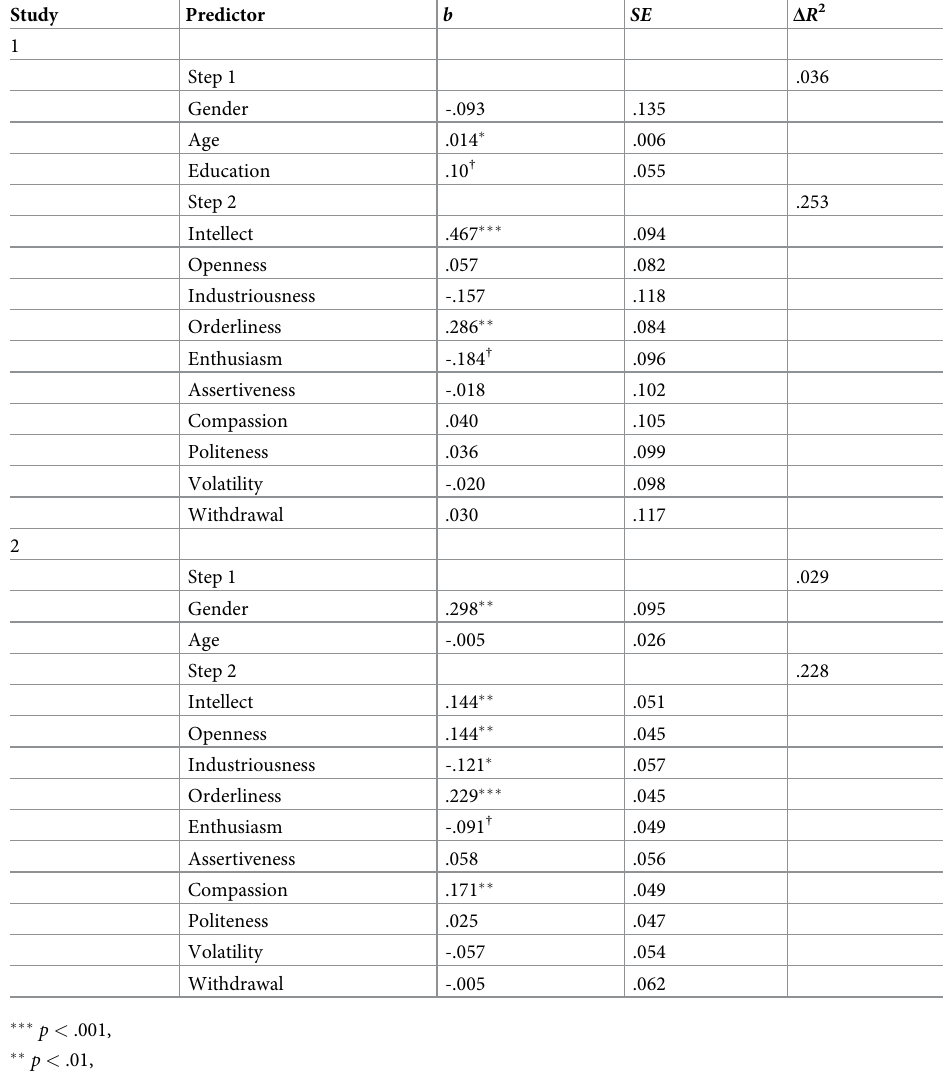
Table 4. Results of hierarchical regression analyses predicting scores on the